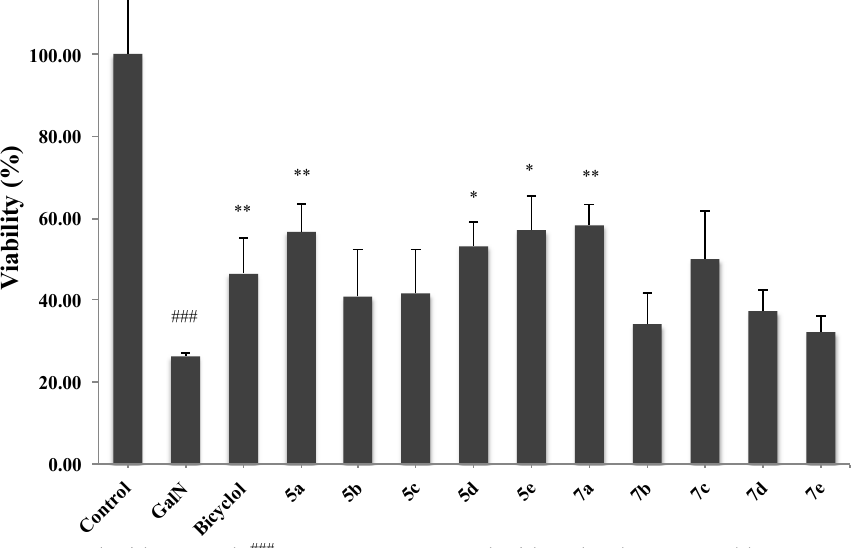
Figure 4. Hepatoprotective activity of goodyeroside A and its analogs on GalN-induced rat hepatocyte injury.